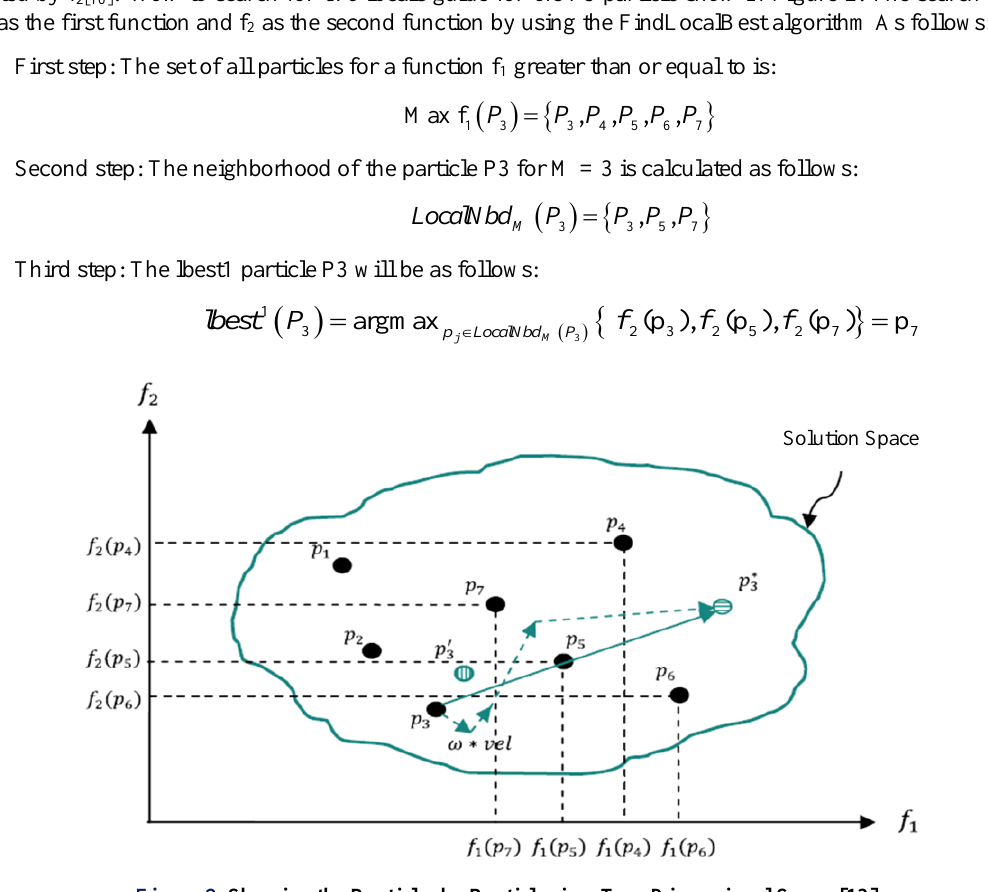
Figure 2. Showing the Particles by Particles in a Two-Dimensional Space